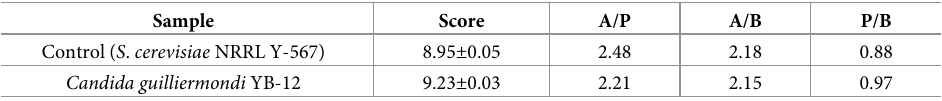
Table 5. Sensory evaluation and ratios of FA contents in rice wine fermented in a 20 L fermenter. Sample